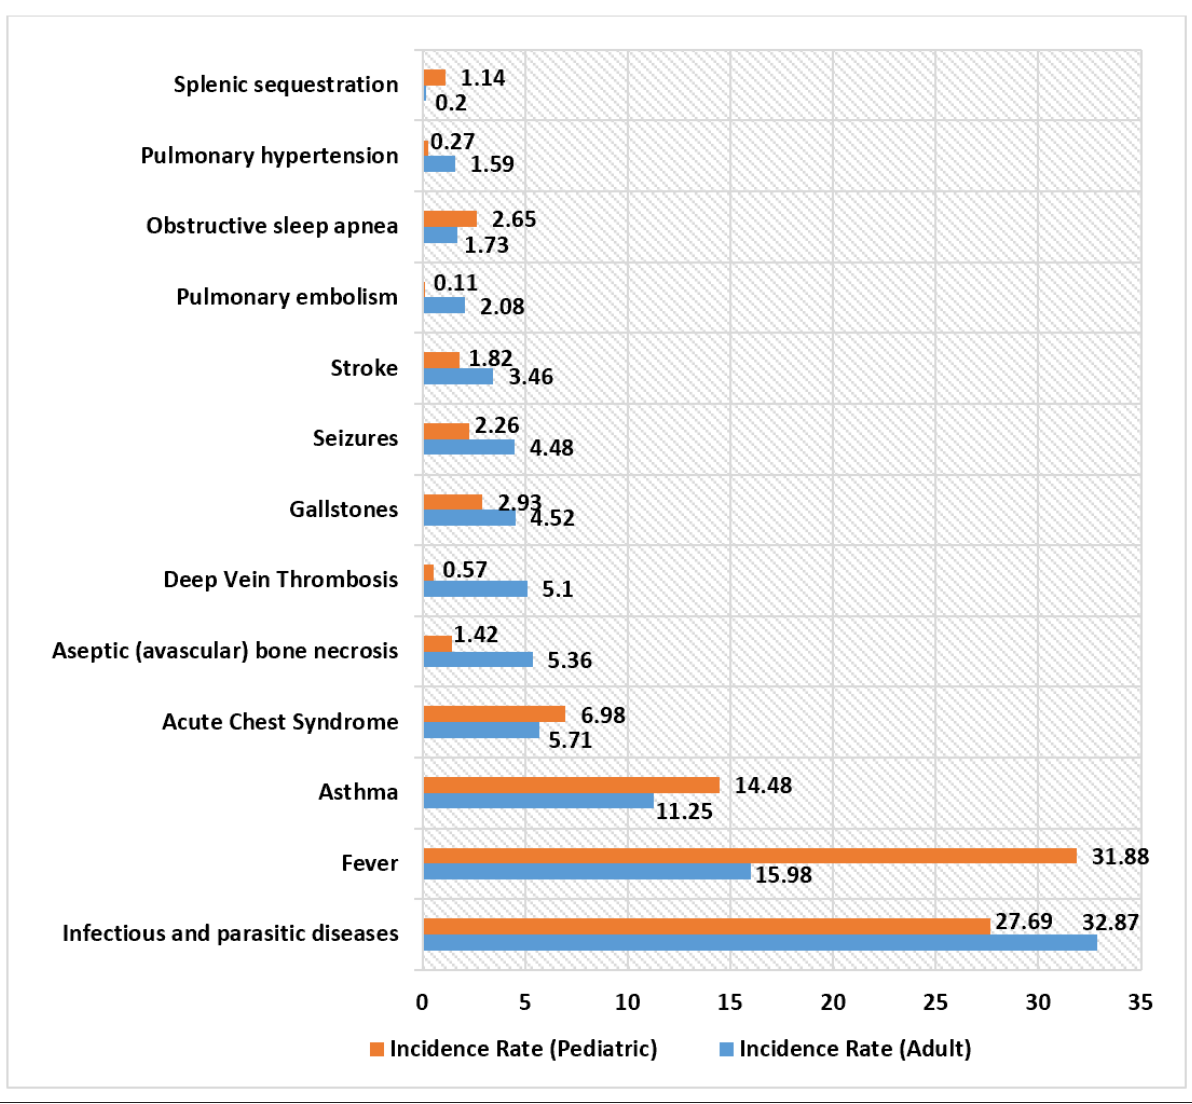
Figure 2. Incidence of Complications in 100 Person-year for Adult and Pediatric SCD